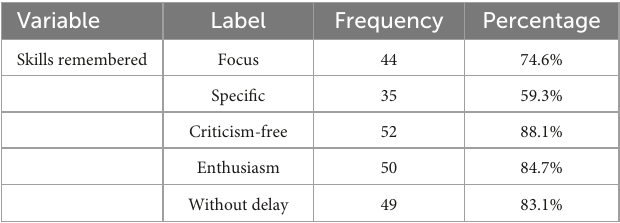
TABLE 3 Descriptive statistics of learned skills N =